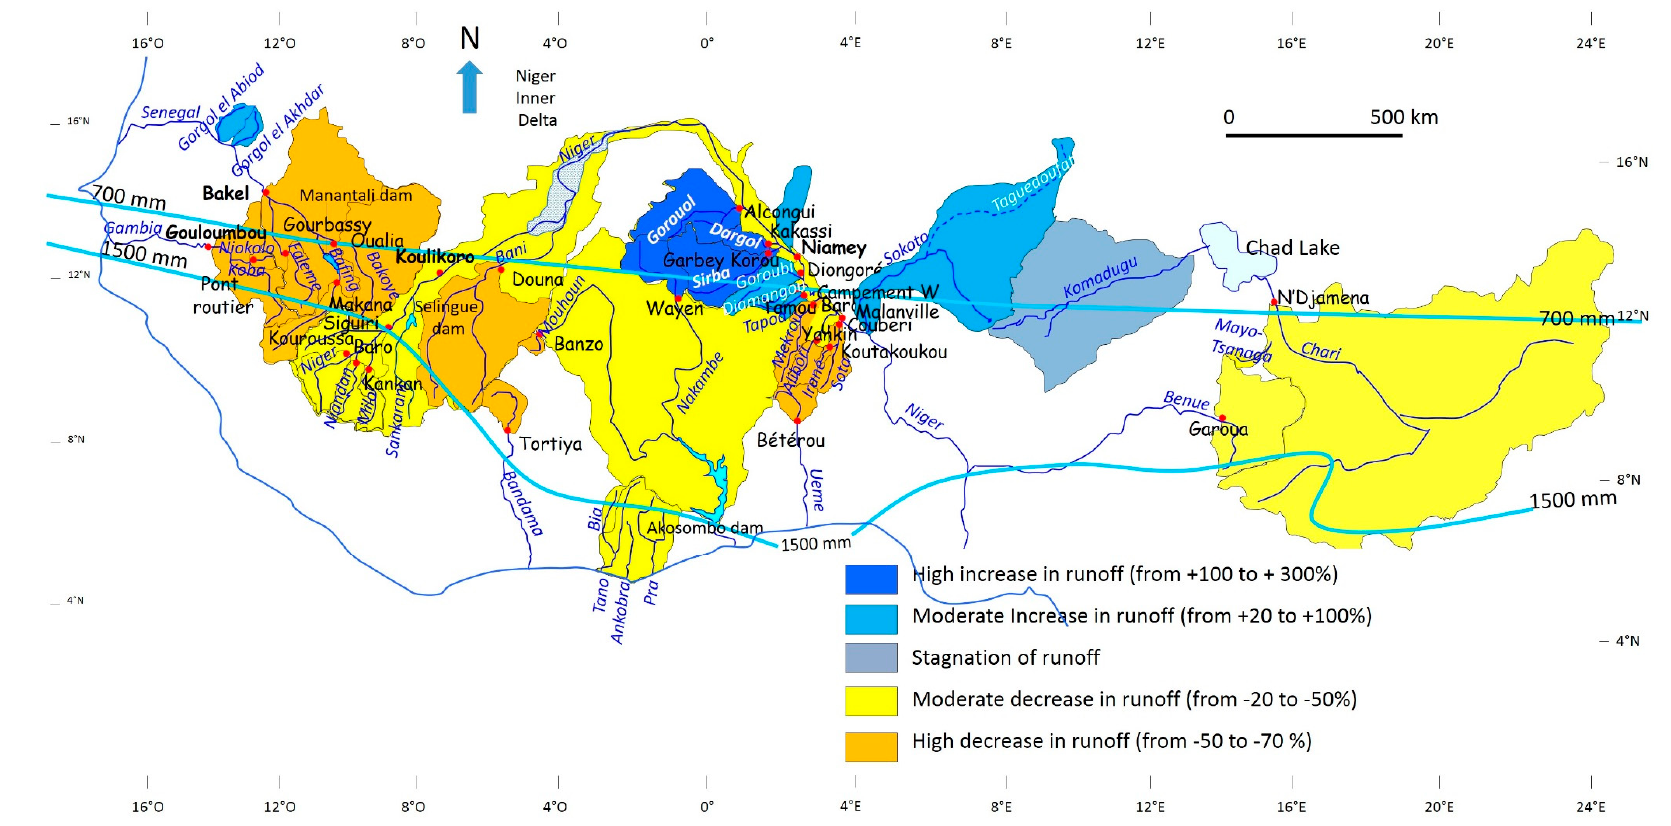
Figure 3. Evolution of river discharges between the 1951–1970 and 1971–2000 periods (updated and completed from [67]). Lines in light blue are the mean 750 and 1500 mm isohyets of the 1951–2000 period.